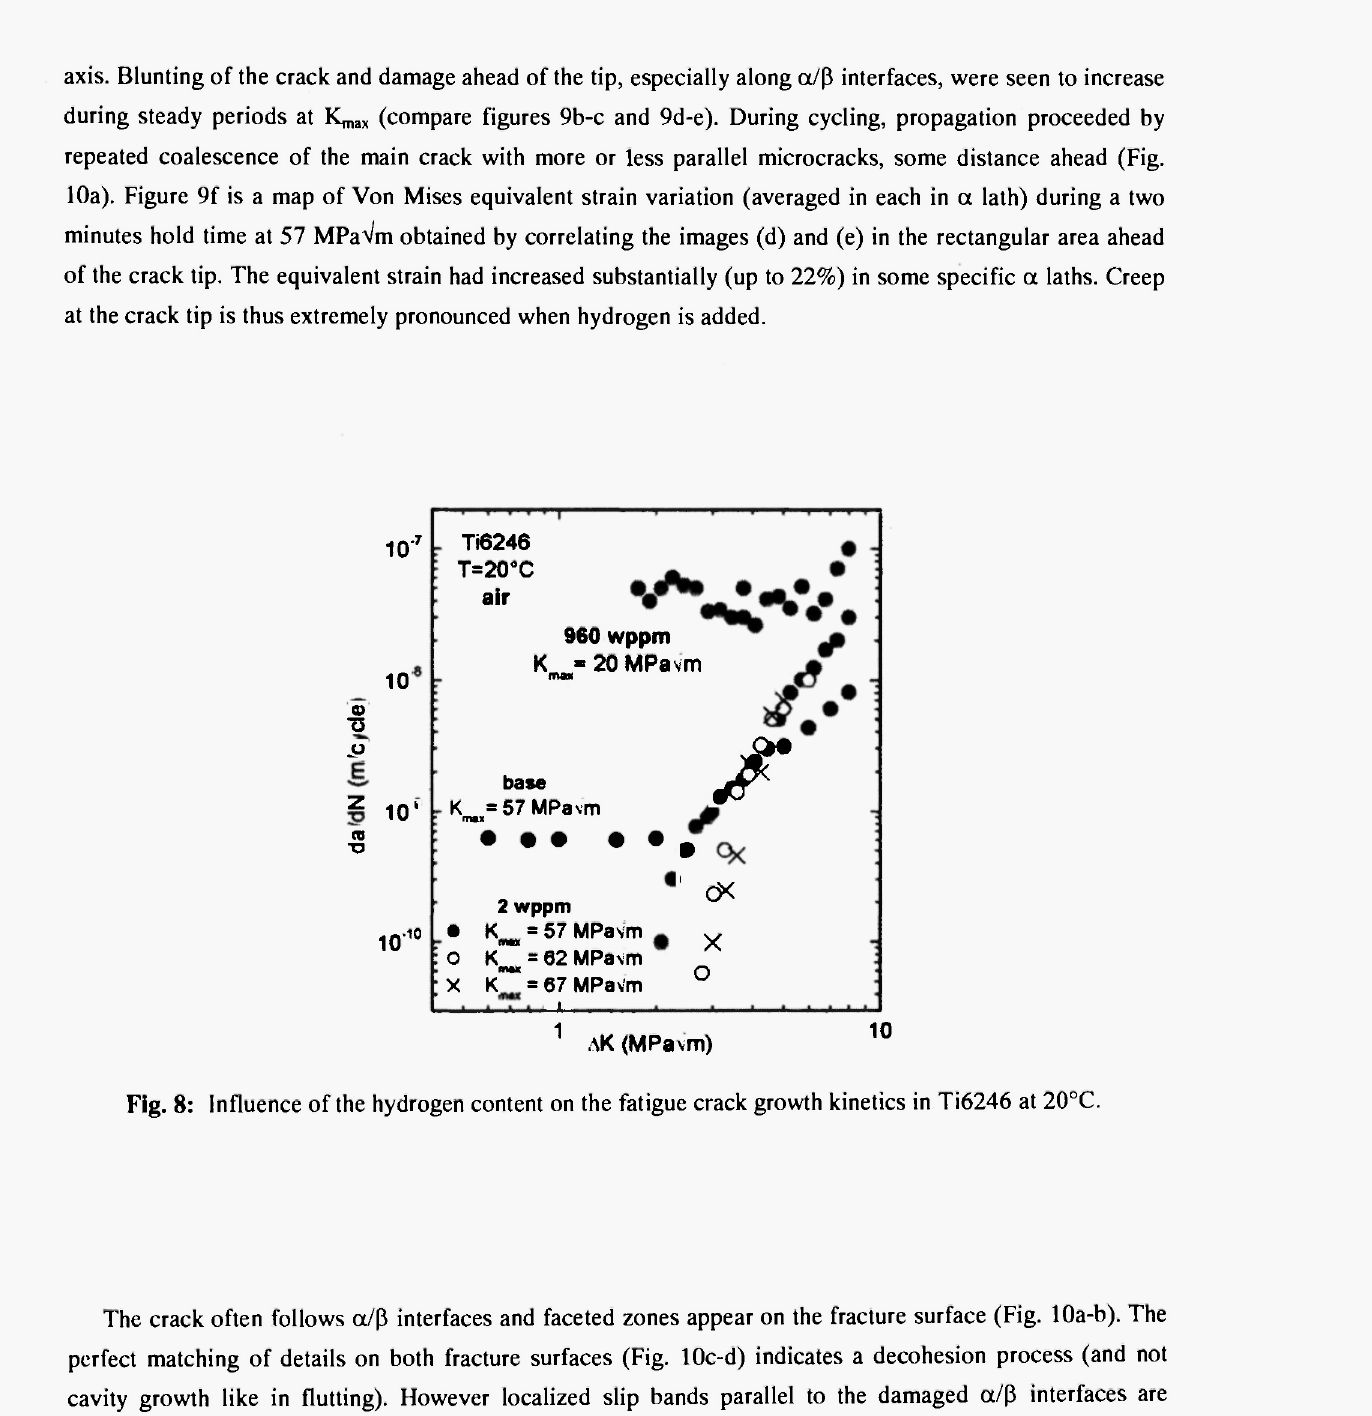
The crack often follows α/β interfaces and faceted zones appear on the fracture surface (Fig. lOa-b). The perfect matching of details on both fracture surfaces (Fig. lOc-d) indicates a decohesion process (and not cavity growth like in flutting). However localized slip bands parallel to the damaged α/β interfaces are present in the α laths very near the interface and the out-of-plane relative displacement associated with interfacial damage (see Fig. 10a) seems coherent with ductile shear decohesion along facets inclined 45° to the free surface rather than tensile brittle decohesion normal to the applied